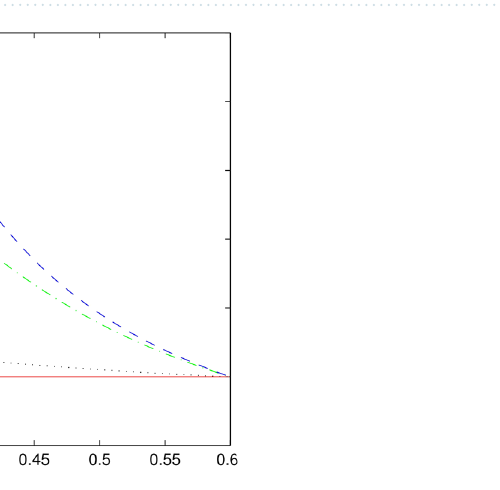
Figure 5. (color online) Acoustic concentrator. ( a ) ideal case, ( b ) impedance-tunable case with p = 1; ( c ) impedance-tunable case with p = 2.